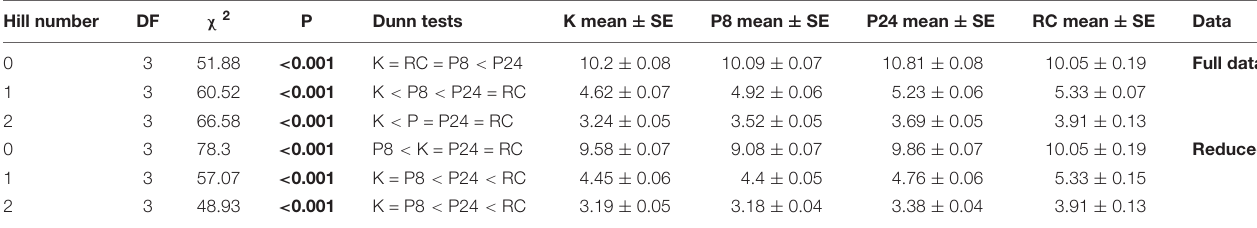
TABLE 1 | Results of Kruskall Wallis and post-hoc Dunn test for 0D, 1D, 2D calculated from the monitoring programs both the full taxa list (Full, 72 taxa for KFMP, K, and PISCO, P, and 33 for Reef Check, RC) and the shared list (Shared, 31 sp., in all programs). Hill number